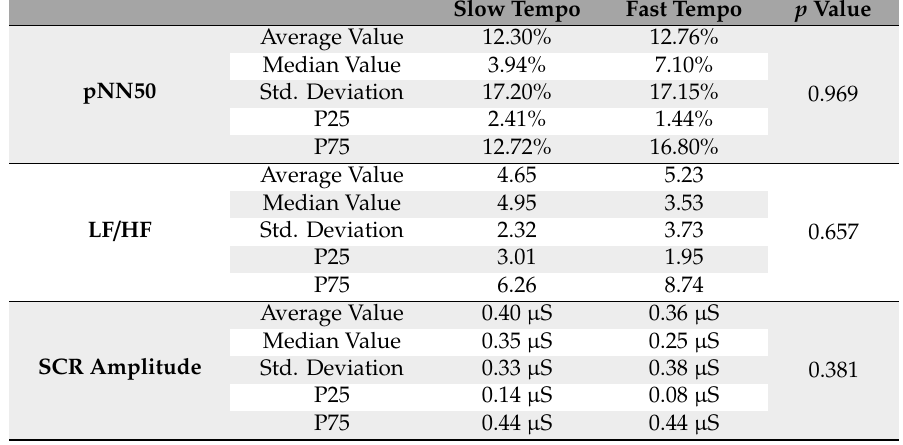
Table 14. Heart rate variability and skin conductivity during the driving test grouped by music tempo. Slow Tempo Fast Tempo p Value